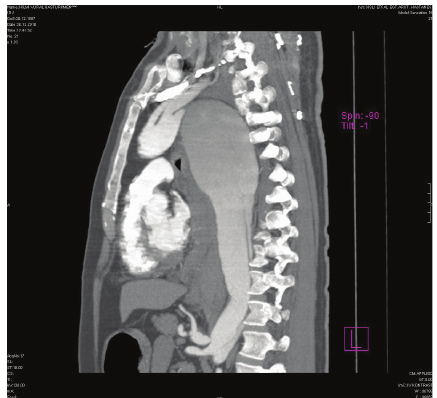
Figure 2: Sagittal MPR image, intimal flap extending from proxi- mal descending thoracic aorta to bifurcation level is demonstrated.